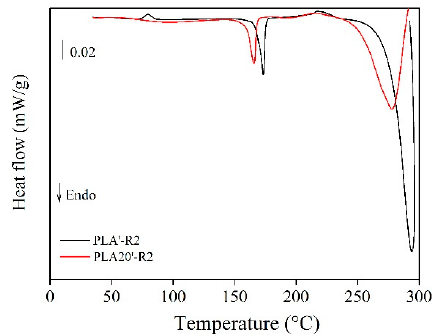
Figure 10. Calorimetric curves for new recycled (R2) PLA’-R2 and PLA20 ′ -R2 samples.